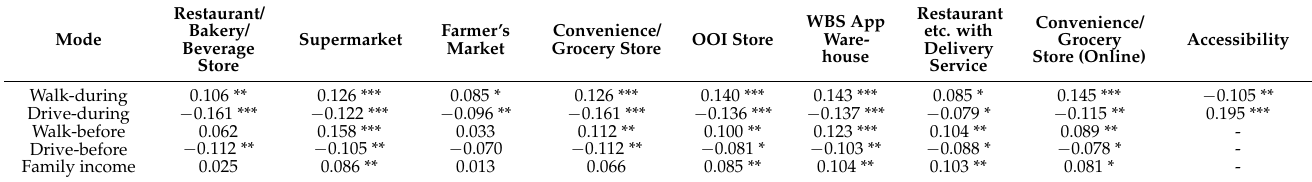
Table 5. Correlation between transportation mode, family income, and the community food